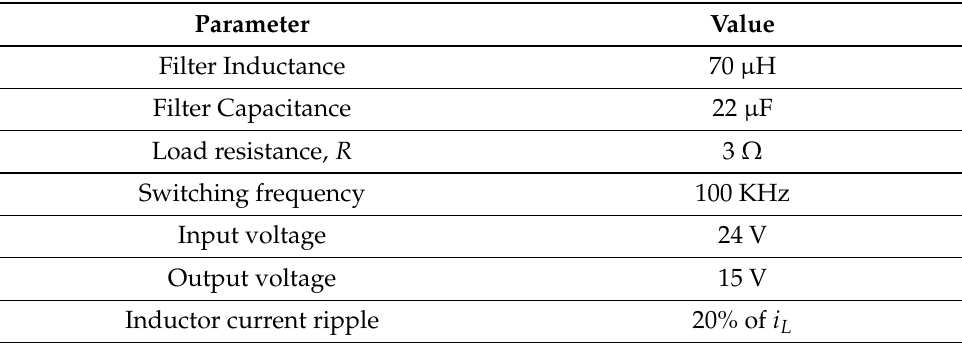
Figure 3. Buck converter with FOPID controller. Table 1. Buck Converter Circuit